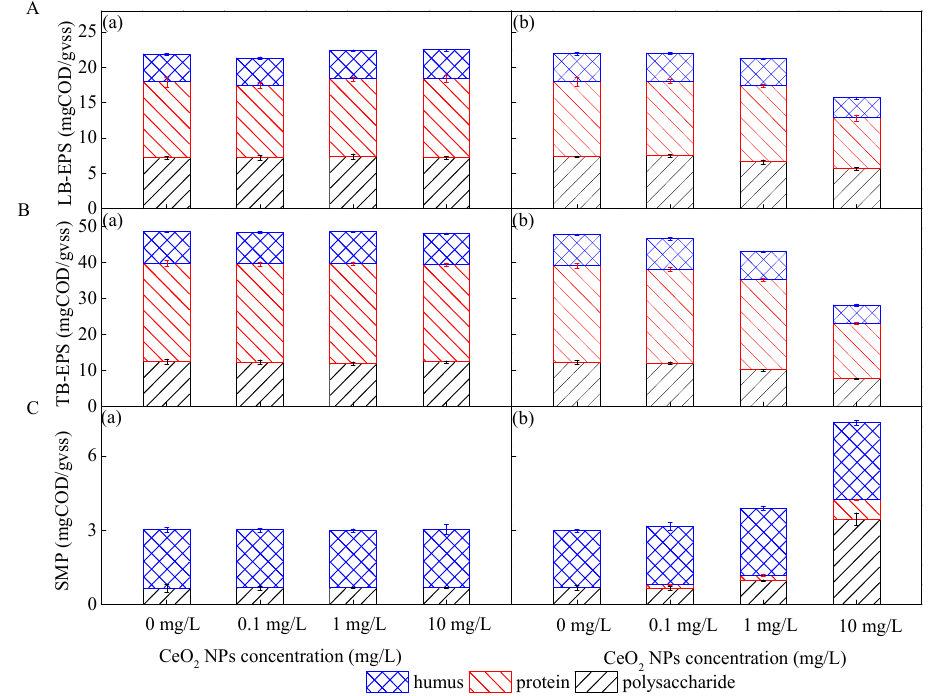
Figure 5. The contents and components of loosely bound extracellular polymeric substances (LB-EPS) ( A ), tightly bound extracellular polymeric substances (TB-EPS) ( B ), and soluble microbial products (SMP) ( C ) extracted from active sludge exposed to CeO 2 NPs at different concentrations during one cycle after 1 day ( a ) and 10 weeks ( b ), respectively. Error bars represent standard deviations of triplicate measurement.